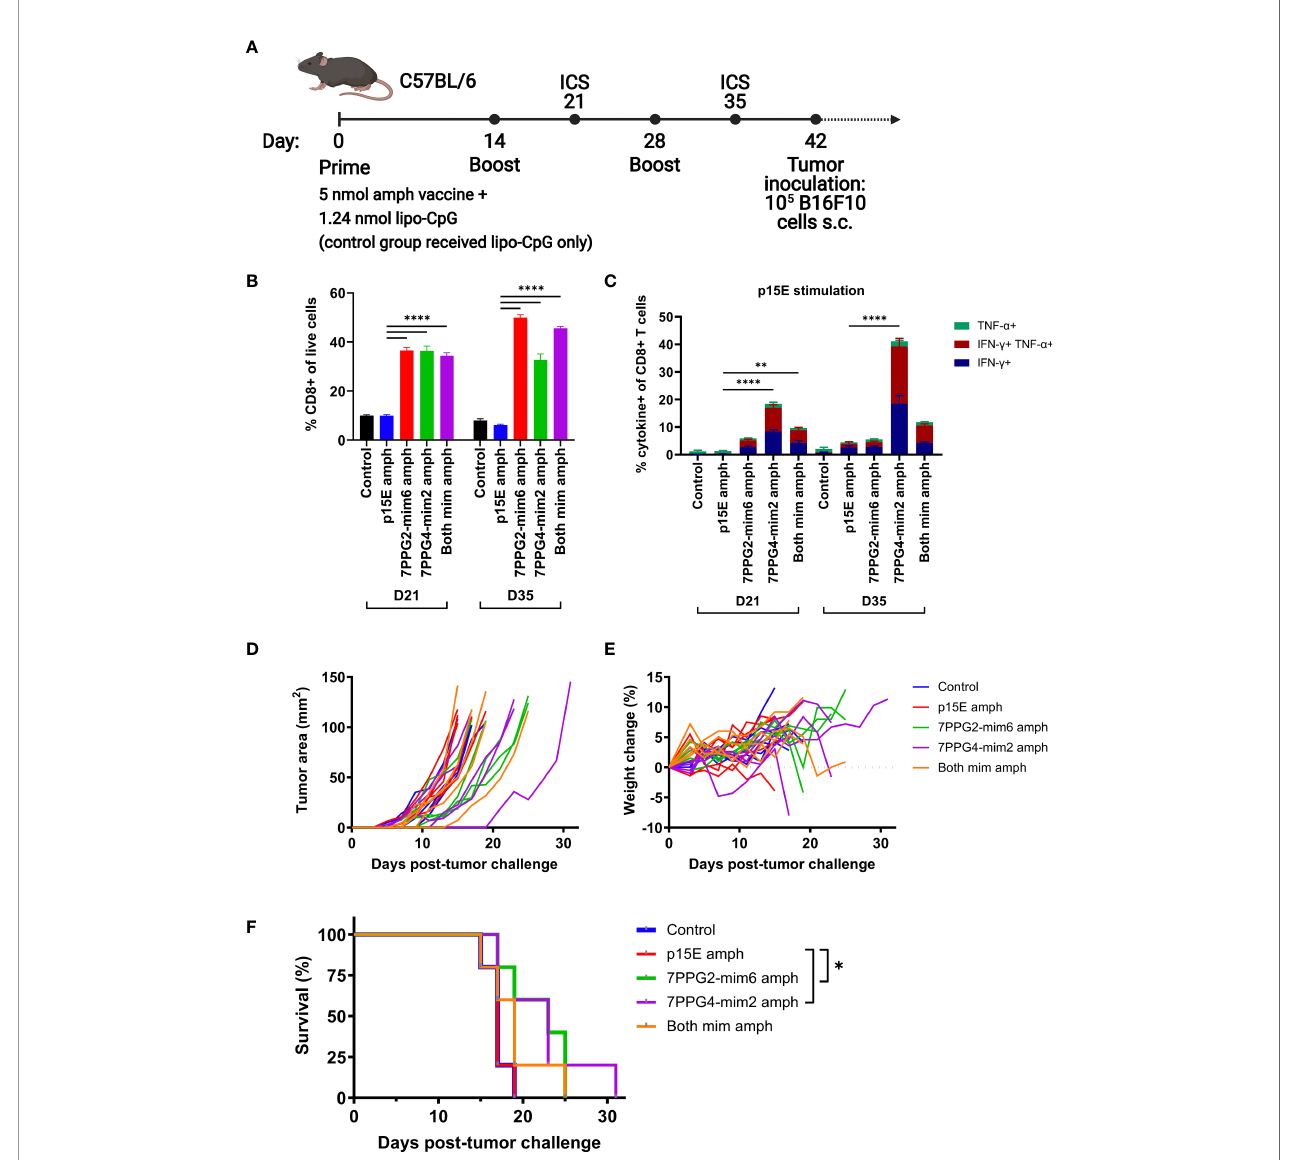
FIGURE 7 | Vaccination against mimotopes promotes the expansion of CD8 + T cells reactive to p15E and can result in tumor growth delay. (A) Timeline of vaccination and tumor inoculation with B16F10 cells (ICS = intracellular cytokine staining, s.c. = subcutaneous). (B – C) On days 21 and 35, peripheral blood samples from each mouse were stimulated with p15E peptide in the presence of brefeldin A for 4 hours. Intracellular cytokine staining was performed to assess the fraction of CD8 + T cells within live cells (B) and CD8 + T cell reactivity to p15E peptide (C) . **P < 0.01, ****P < 0.0001 by one-way ANOVA with Tukey ’ s multiple comparisons test. Data shown are mean+s.e.m. (D – F) Tumor areas and weight were measured every other day beginning 3 days post- inoculation. Mice were euthanized when tumor area exceeded 100 mm 2 . Shown are tumor areas for individual mice (D) , weight change from starting weight (E) , and survival (F) . *P < 0.05 by log-rank (Mantel-Cox) test. N=5